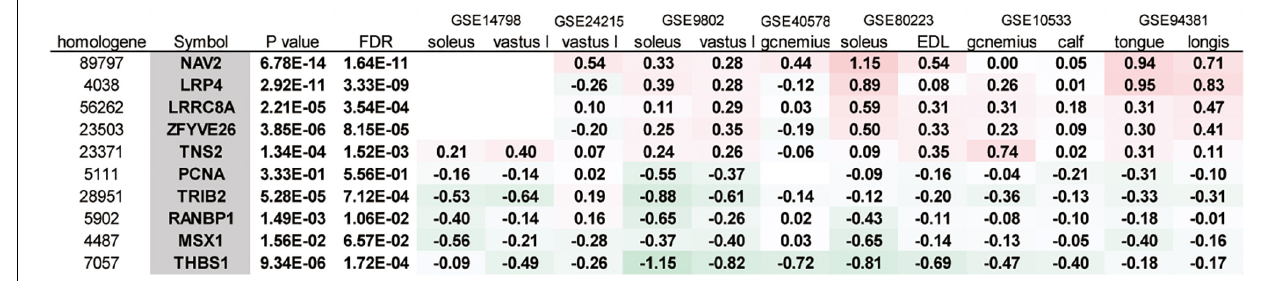
FIGURE 3 | A meta-analysis of gene expression in muscle samples in response to microgravity conditions. The 10 genes exhibiting changes in expression in the same direction (all increasing or decreasing) in most of the datasets were listed. vastus l, vastus lateralis; gcnemius, gastrocnemius; EDL, extensor digitorum longus; longis, longissimus dorsi.